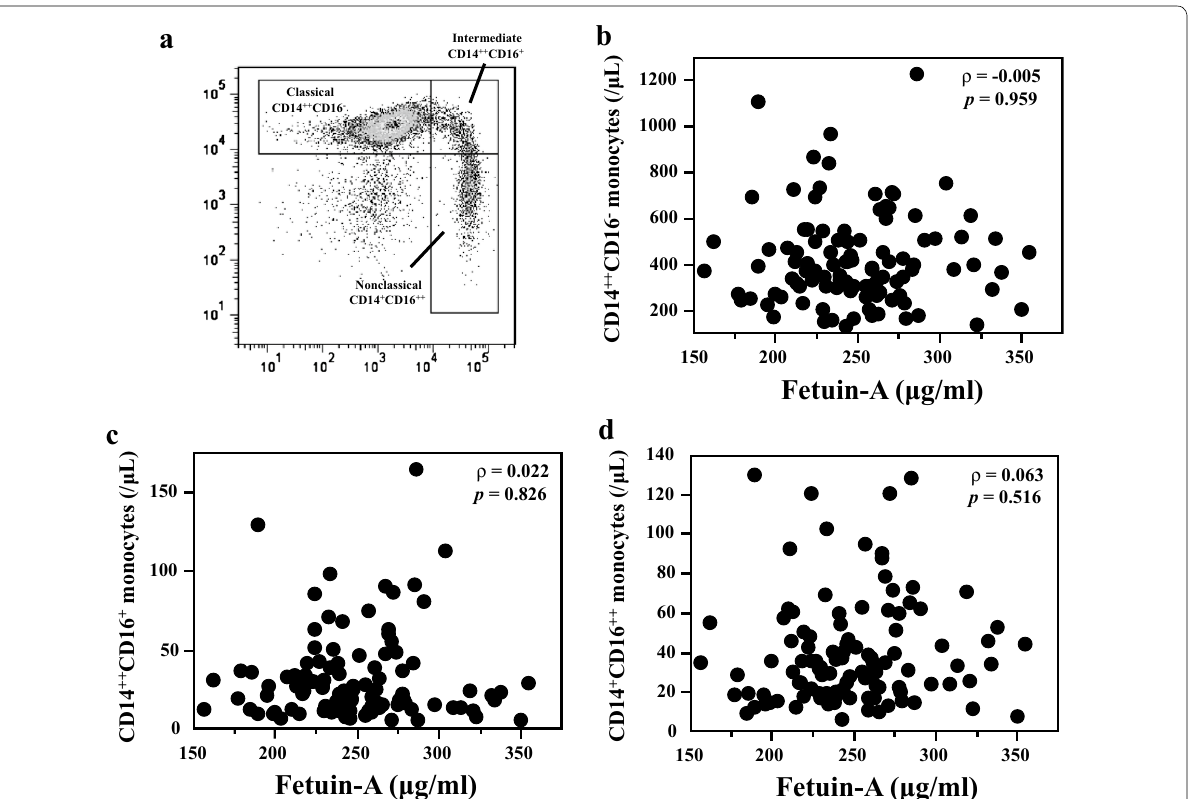
Fig. 1 The flow cytometric analysis of monocyte subsets (representative example; a ) and the association of serum levels of fetuin-A with monocyte subsets ( b – d